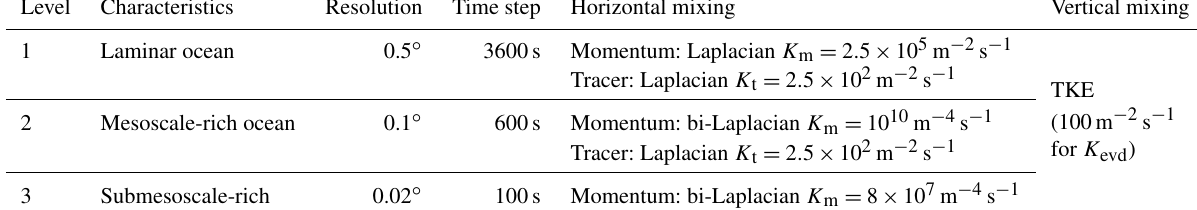
Table 1. Model configurations of the resolution hierarchy of three levels. Level